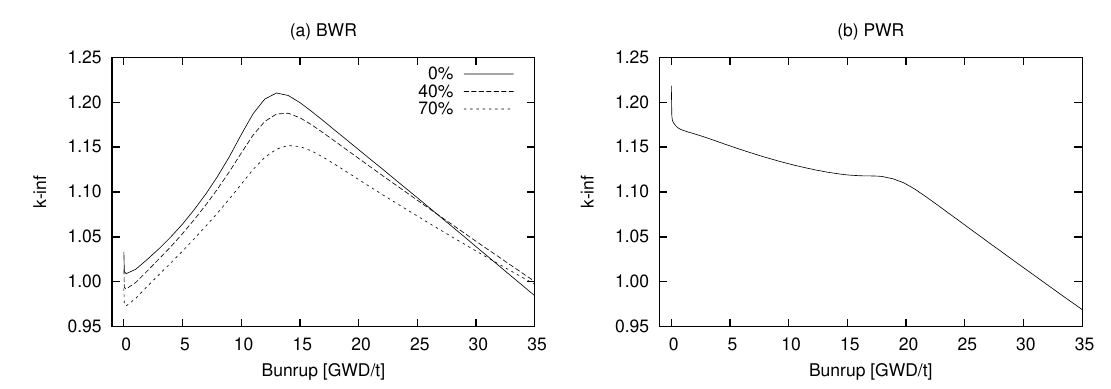
Figure 2: k calculated with ∞